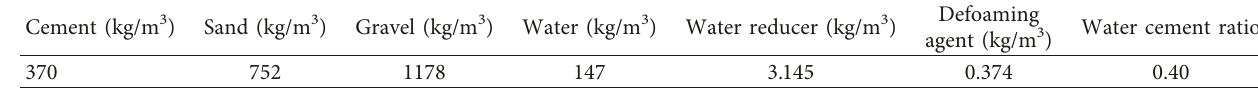
Table 1: Cement concrete mixture ratios.